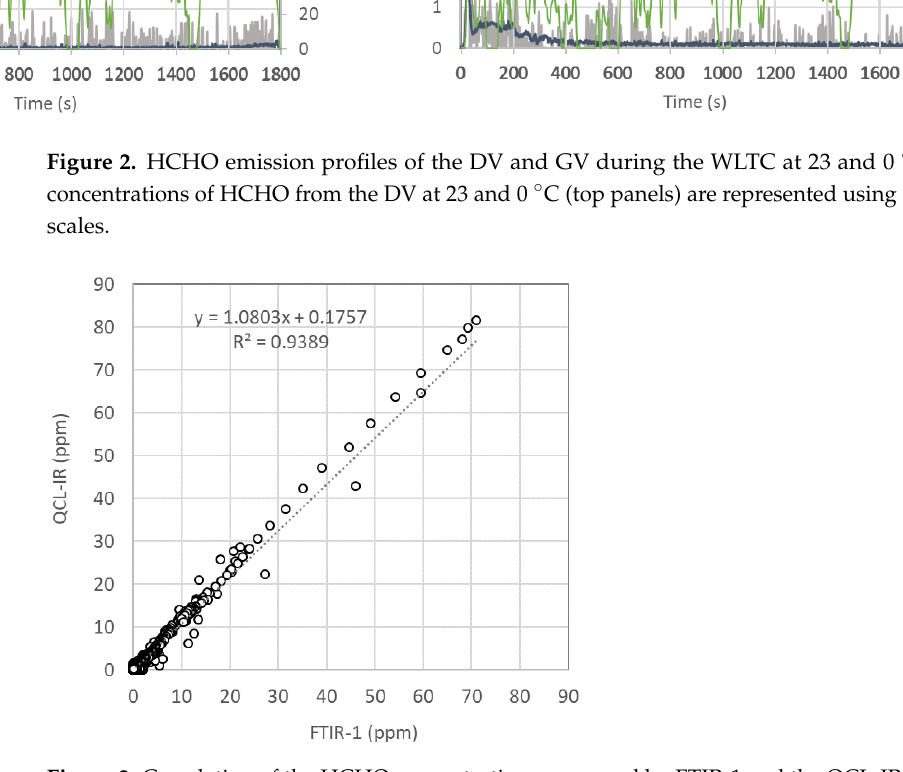
Figure 3. Correlation of the HCHO concentrations measured by FTIR-1 and the QCL-IR from the DV and the GV during the WLTC at 23 and 0 °C.